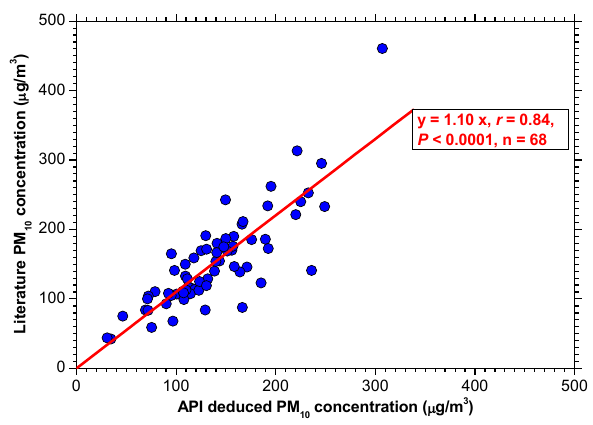
Fig. 2. Linear correlation between the API-deduced PM 10 concen- trations and the literature reported PM 10 concentrations. The data used in this analysis are adapted from those shown in the Supple- mentary material 1 – Validation of the API deduced PM 10